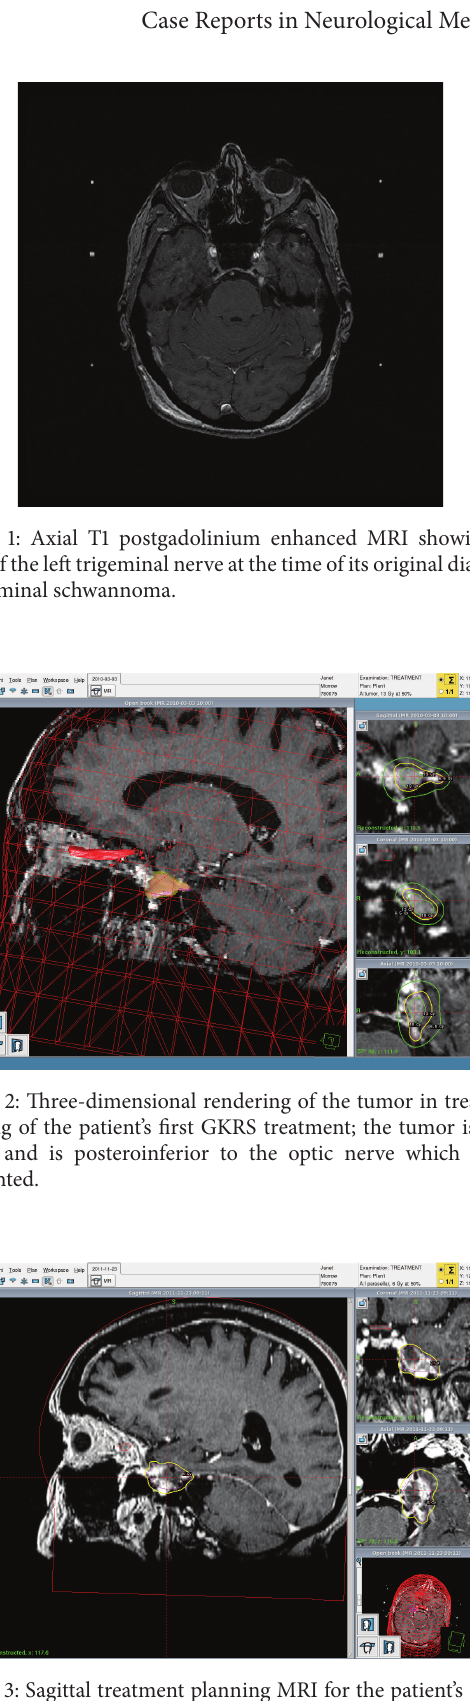
Figure 3: Sagittal treatment planning MRI for the patient’s second GKRS treatment showing increased size and the tumor with the Gamma Knife isodose lines in coronal, sagittal, and axial